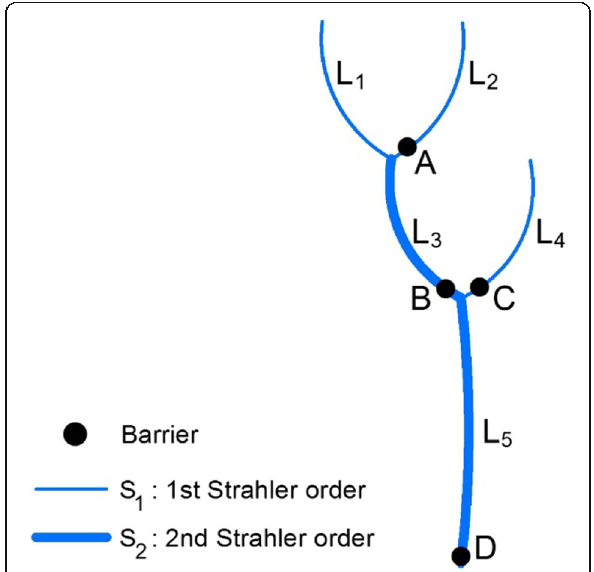
P 5 L j S j = 9. For j ¼ 1